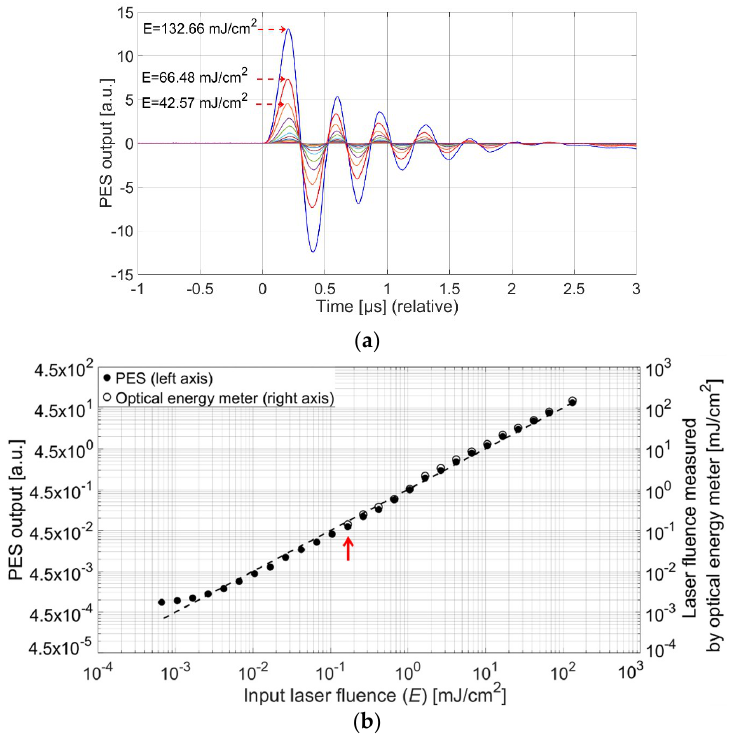
Figure 3. ( a ) Ultrasound waveforms measured by PES for an incident laser energy fluence of 132.66 mJ/cm 2 –156.96 nJ/cm 2 . ( b ) Comparison of the pulse laser energy fluence measured by PES (filled circle; left axis) with the reference measured by the optical energy meter (empty circle; right axis). Here, the dotted line indicates when an input optical fluence from the Nd:YAG laser is the same as the output fluence detected by the optical energy meter. Note that the lower range of fluence (below the arrow) could not be measured by the reference detector.